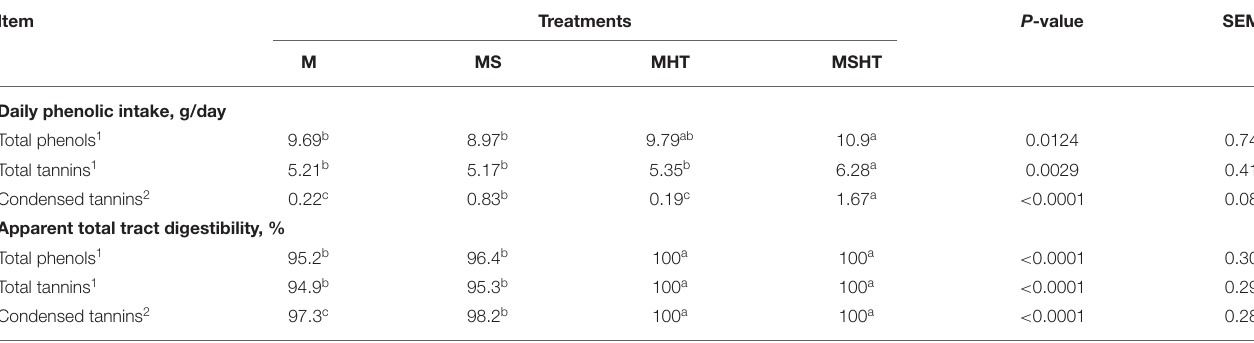
TABLE 4 | Phenolic compounds intake and digestibility of dogs fed the experimental diets.